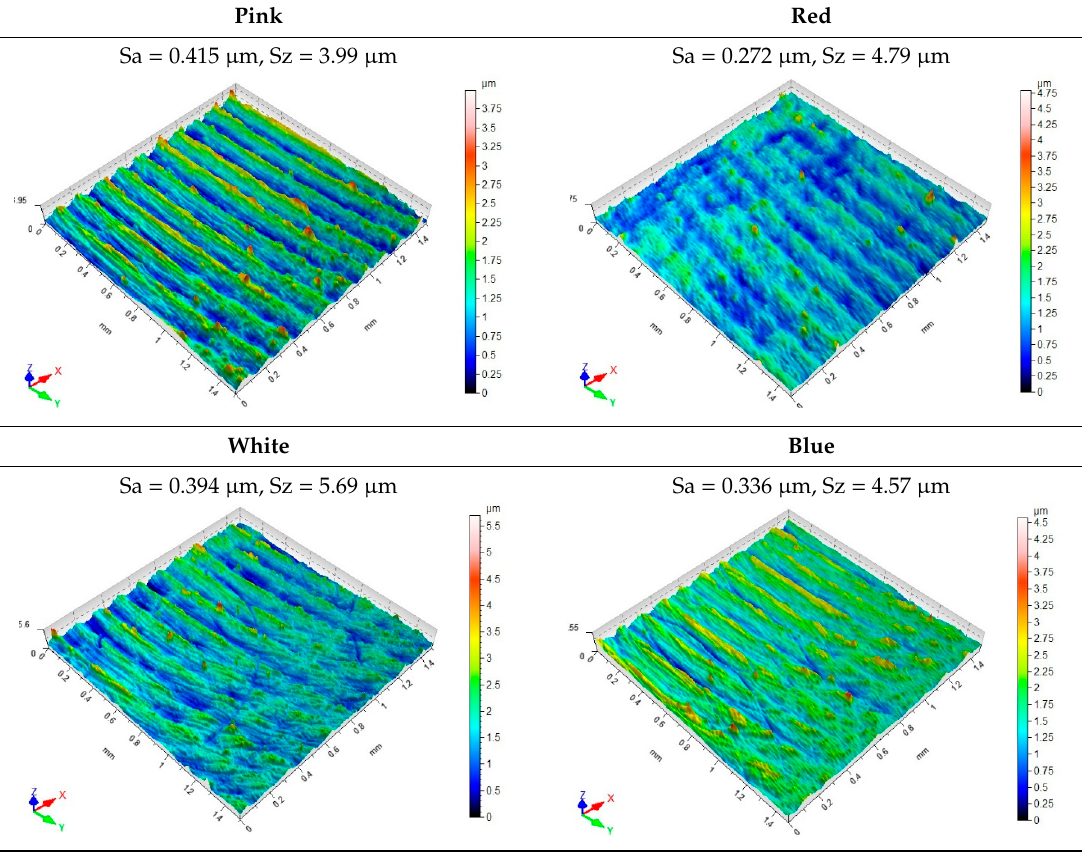
Table 3. Surface topography after brushing with the “low” spring in the offset adjustment sleeve.